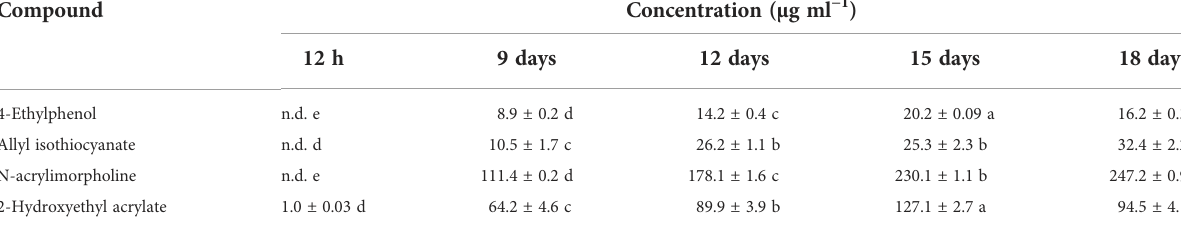
TABLE 2 The concentration of goosegrass-suppressed active substances in different decay duration decomposition leachates.